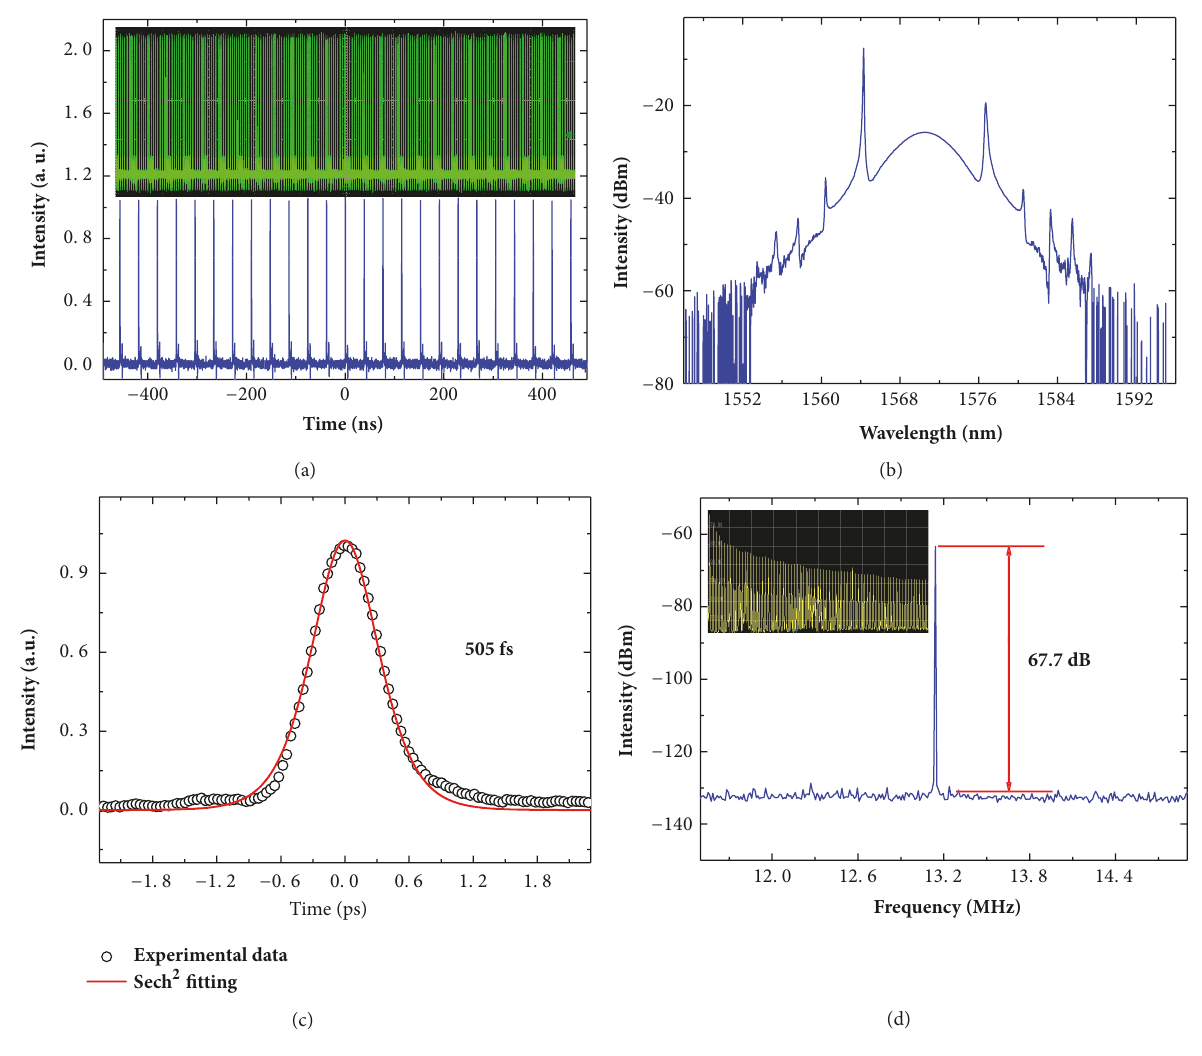
Figure 4: Single pulse mode-locking results of fiber